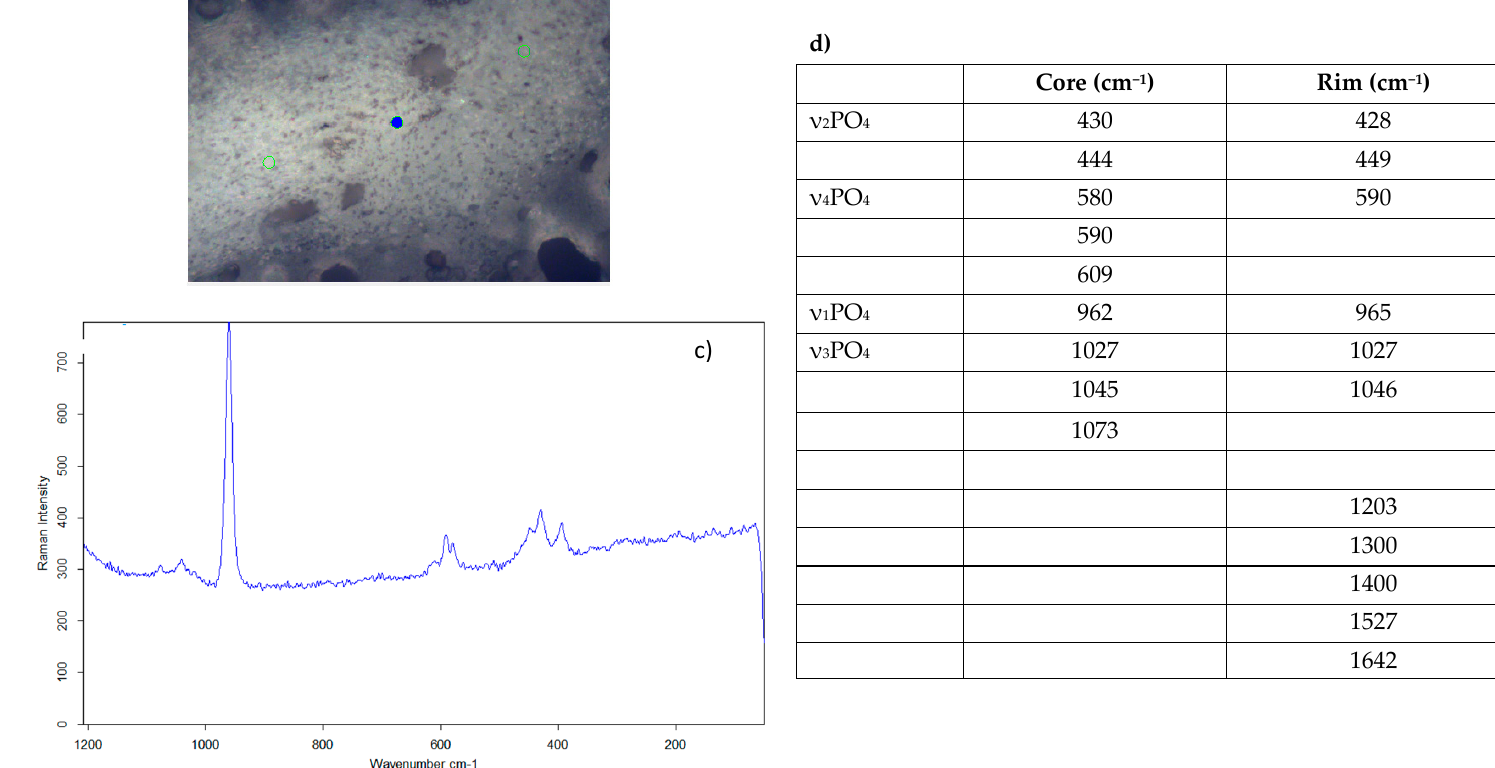
Figure 48. µ -Raman spectra acquired on the ( a ) core and the ( b ) rim of bigger Ca-phosphate inclusions (KH_G10 light blue natron-based Egypt I glass tessera from Khirbet al-Mafjar, Palestine [23]). Attribution of bands in the spectra is provided below, in Figure 48d. ( c ) µ -Raman spectra acquired on smaller, more compact Ca-phosphate inclusions, consisting hydroxyapatite (KH_G10 light blue natron-based Egypt I glass tessera from Khirbet al-Mafjar, Palestine [23]); and ( d ) bands attribution according to [104,109,110].